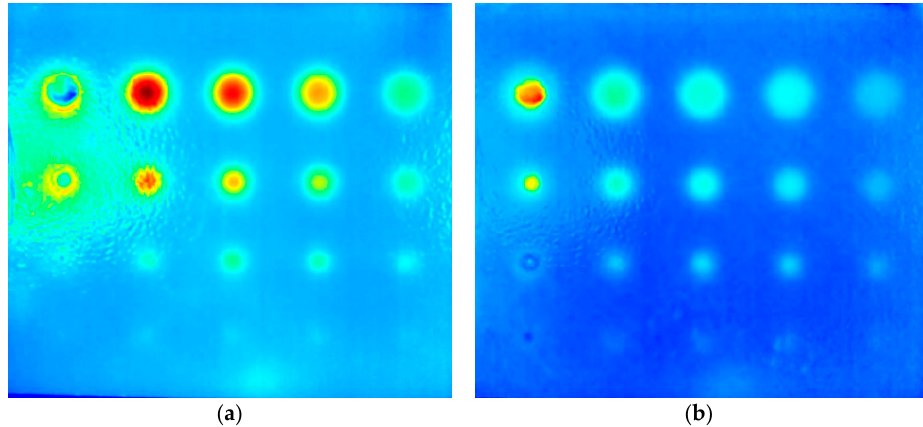
Figure 11. ( a ) Amplitude image and ( b ) phase image of thermograms captured during heating for 75 s.